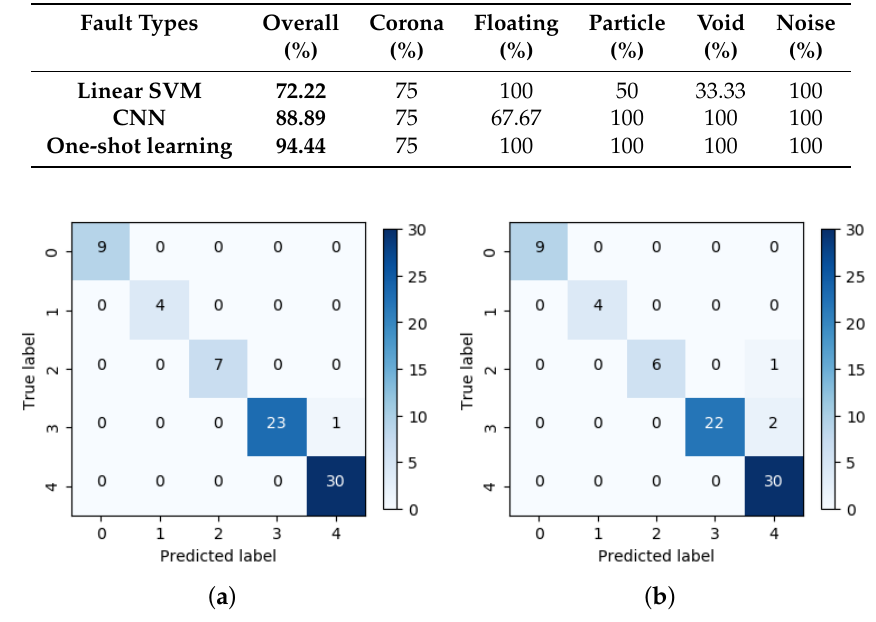
Figure 9. Confusion matrix with whole data case: ( a ) One-shot learning, ( b ) CNN.